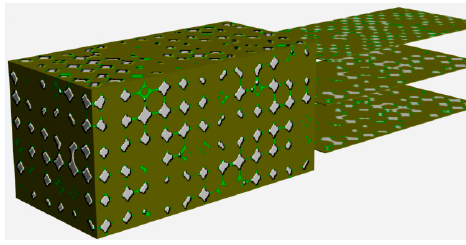
Figure 11. Three-dimensional simplified model diagram of core 24 # ( α s = 0.25).